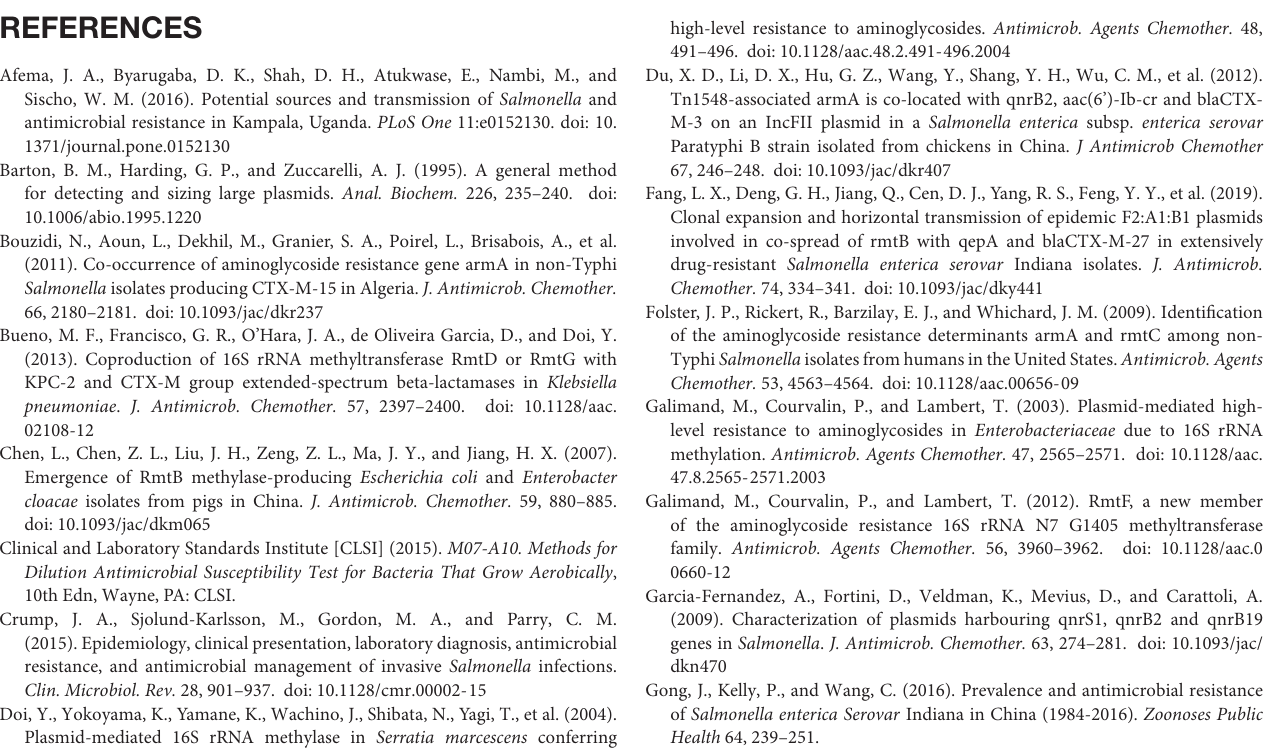
Supplementary Table 1 | Primers used in this study for polymerase chain reaction. Supplementary Table 2 | The conjugation rates of the armA -harboring